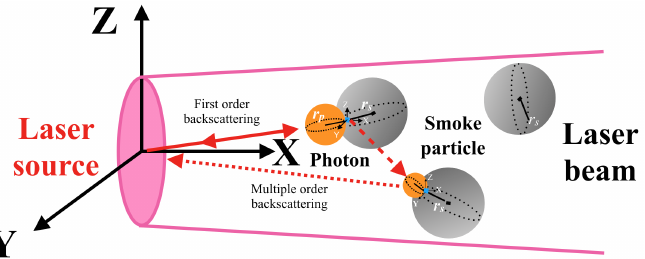
Figure 2. Collision and scattering process of photons and smoke particles.